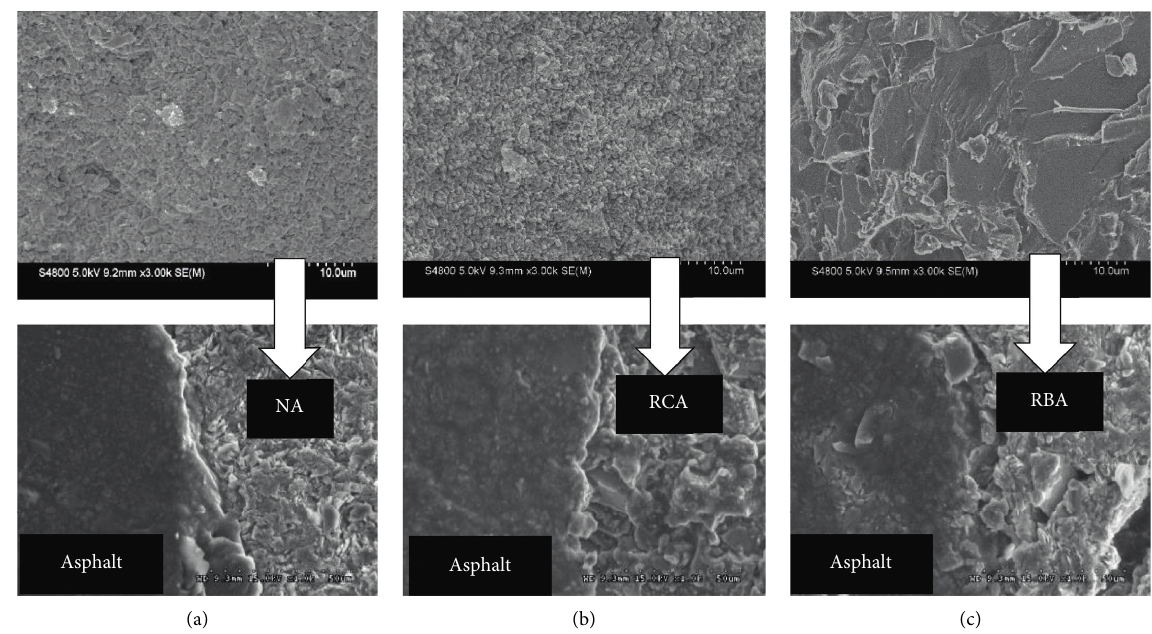
Figure 6: Scanning electron microscope results of three kinds of asphalt